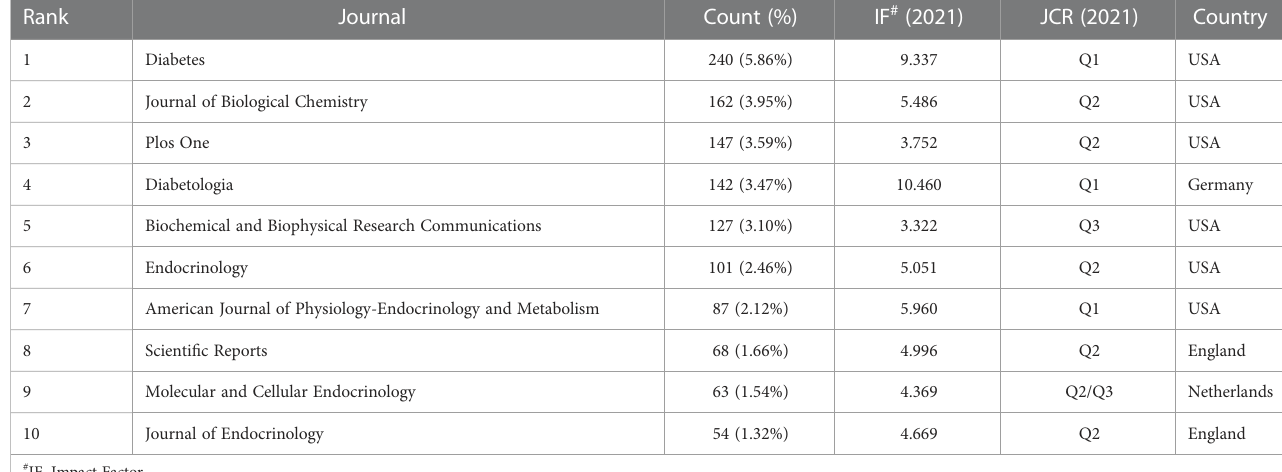
TABLE 3 Top 10 journals related to beta-cell